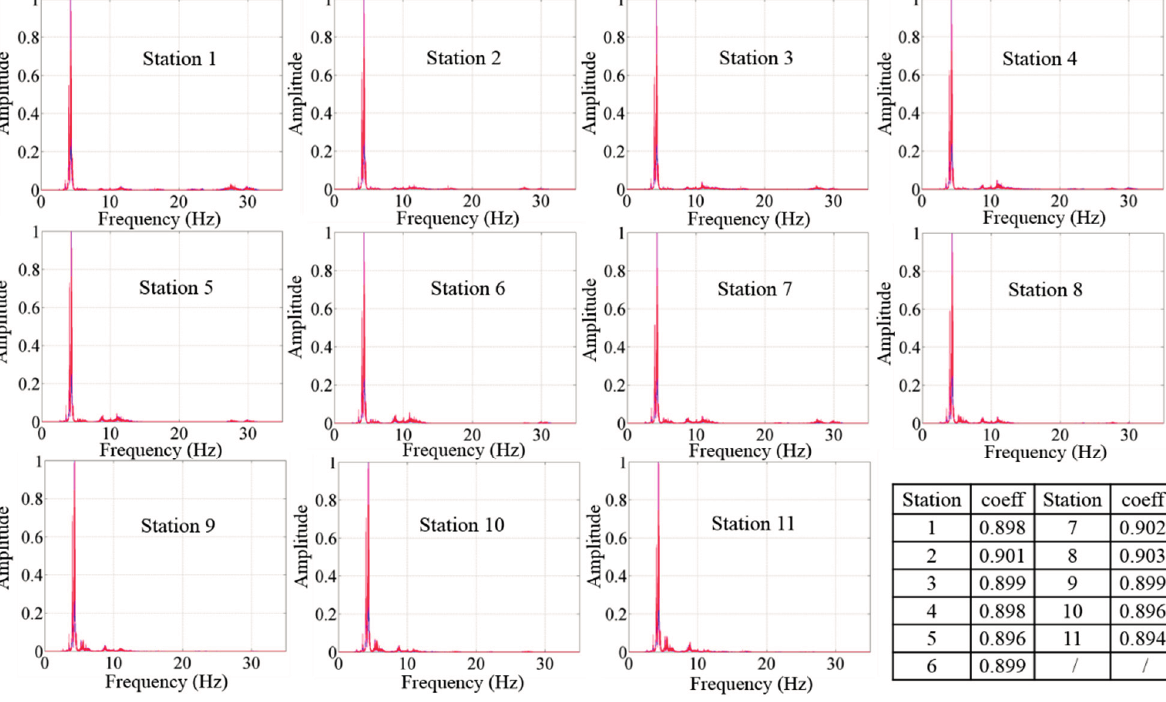
Figure 10. Power spectral densities of signals collected from the cableless geophone (red) and the 4.5 Hz geophone (blue) and the correlation coefficients for each station.